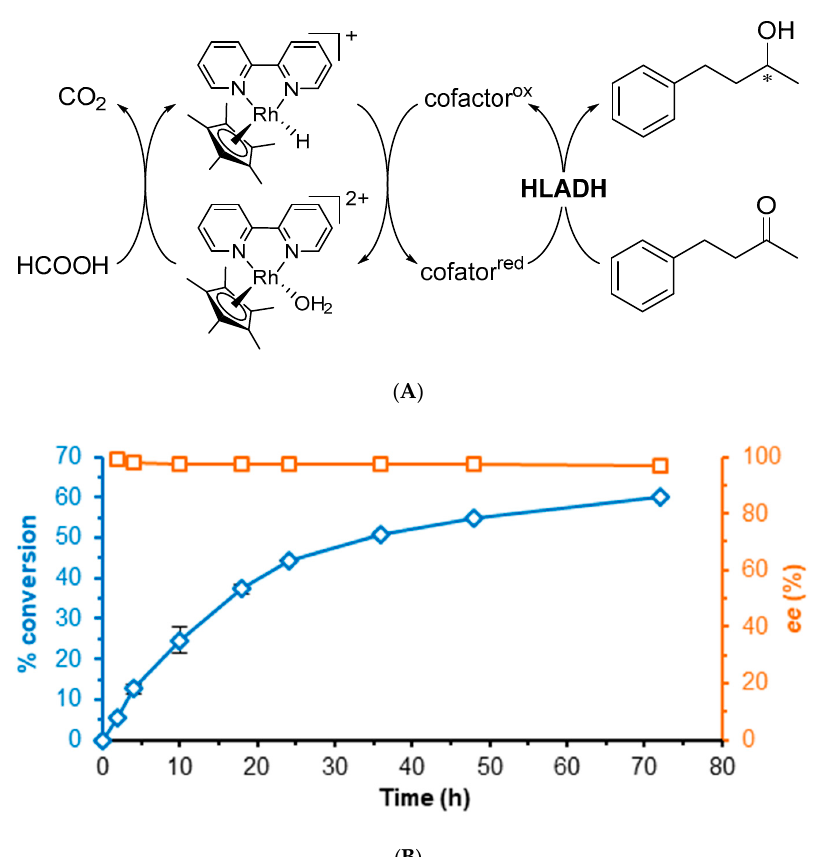
Figure 2. ( A ) Representative scheme of the HLADH-catalyzed reduction of 4-phenyl-2-butanone to enantioenriched 4-phenyl-2-butanol; ( B ) Time course of the reaction (blue diamonds, ee orange squares); NADH regeneration system with [Cp*Rh(bpy)(H 2 O)] 2+ using sodium formate as a hydride source. Reaction conditions: 100 mM KPi pH 7.0, HLADH (2 U), [NAD] = 2.2 mM, [Cp*Rh(bpy)(H 2 O)] 2+ = 0.52 mM, [HCO 2 Na] = 52 mM, [4-phenyl-2-butanone] = 16.7 mM, shaken at 30 ◦ C, 800 rpm. Conversion and ee determined by chiral GC.